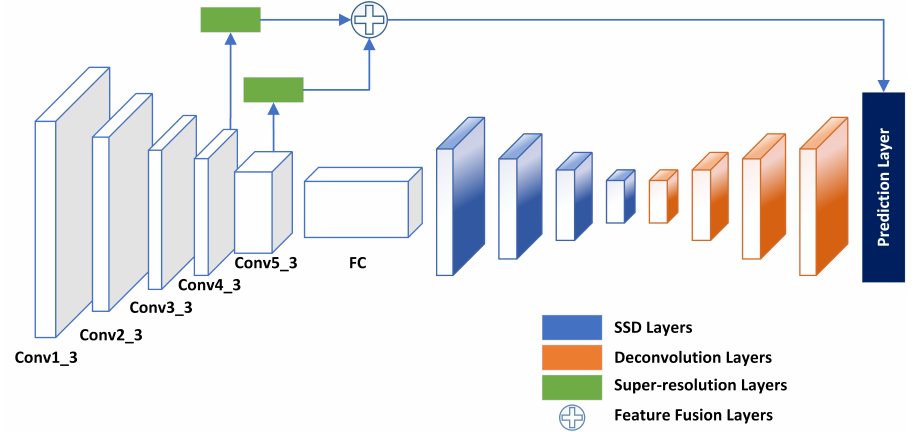
Figure 3. Network architecture of the proposed object detection model. The SSD model is used as the baseline network and extended to include deconvolution module (orange), super-resolution module (green), and shallow layer feature fusion module ( +